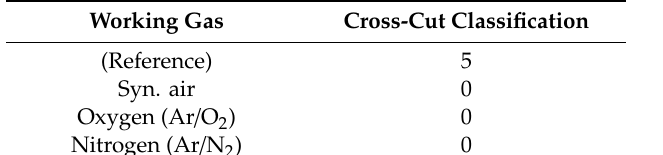
Table 3. Cross-cut classification according to DIN EN ISO 2409 of PP60 before and after plasma treatment with di ff erent working gases.